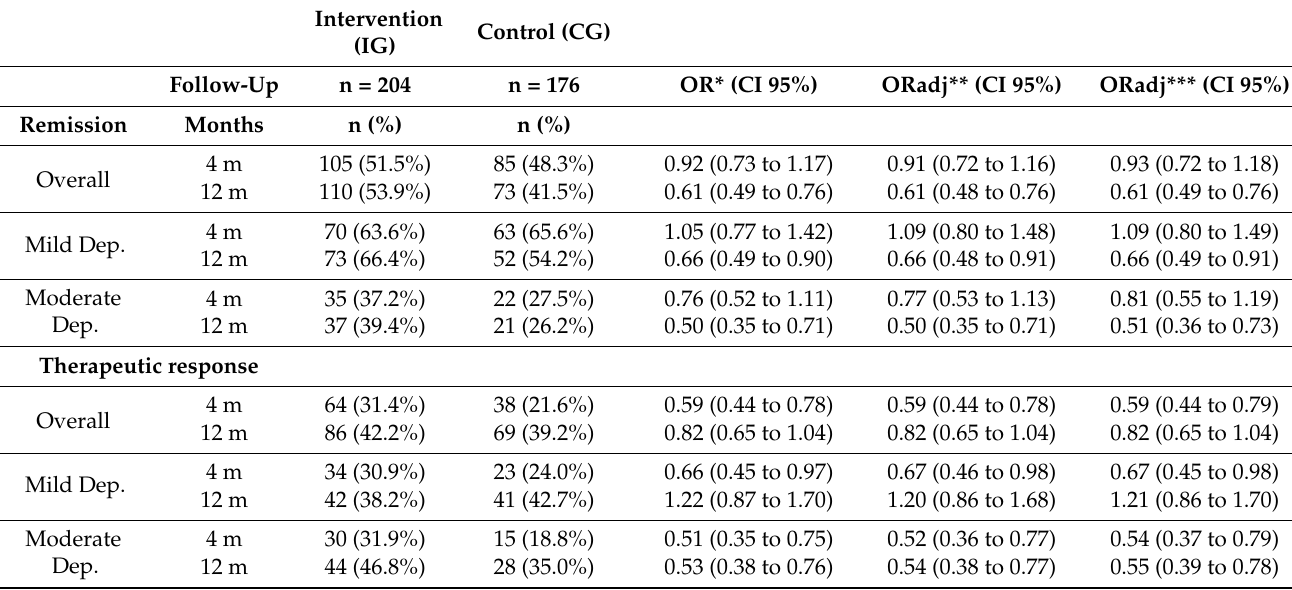
Table 2. Remission and therapeutic response of depression in the overall. mild and moderate depression patients. OR adjusted according to different